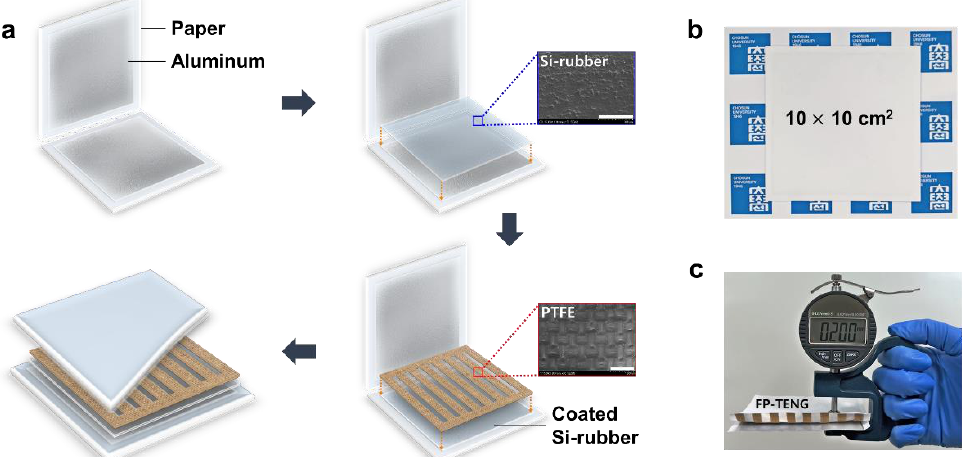
Figure 1. ( a ) Schematic of foldable paper-based triboelectric nanogenerator (FP-TENG) fabrication process. The inset shows FE-SEM images of the coated Si rubber surface PTFE with a scale bar of 300 µm. ( b ) Photograph of FP-TENG with a surface area of 10 cm × 10 cm. ( c ) Thickness of FP-TENG.